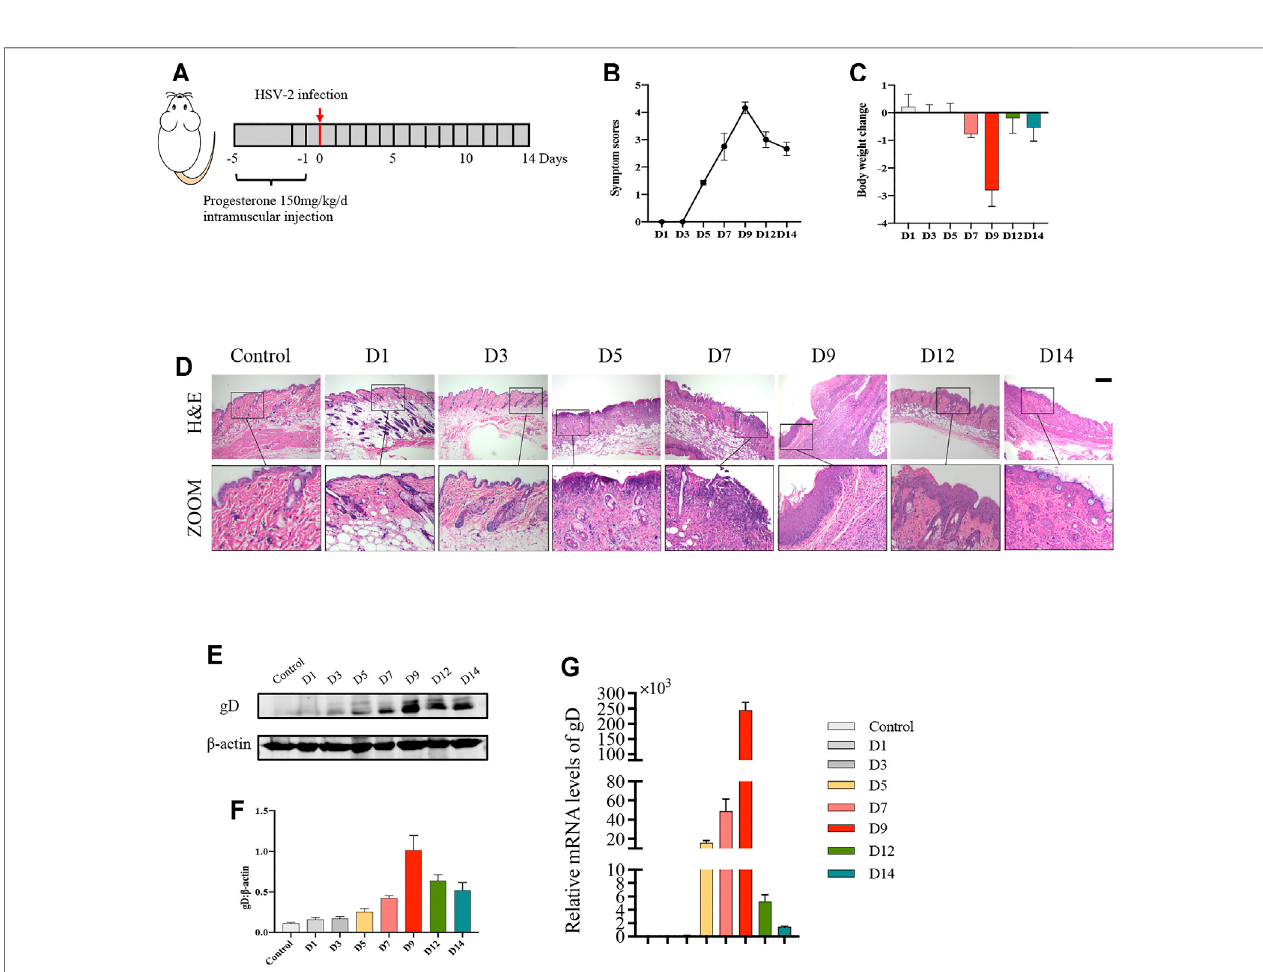
FIGURE 1 | Balb/c mice have the most severe symptoms on the 9th day after HSV-2 infection. (A) The protocol of timepoint exploring for animal experiment. (B) Symptom scores of different groups in each timepoint. (C) Body weight change of different groups in each timepoint (compared with body weight of mice before treatment. (D) Picturesofthevulvaofbalb/cmice. (E) RepresentativewesternblotsforgDproteinexpressionsinvulva. (F) Thequanti fi cationofgDwesternblots. (G) The mRNA levels of gD. All data are presented as means ± SEM. p < 0.05 (*), p < 0.01 (**), and p < 0.001 (***); ( n (cid:2) 6).